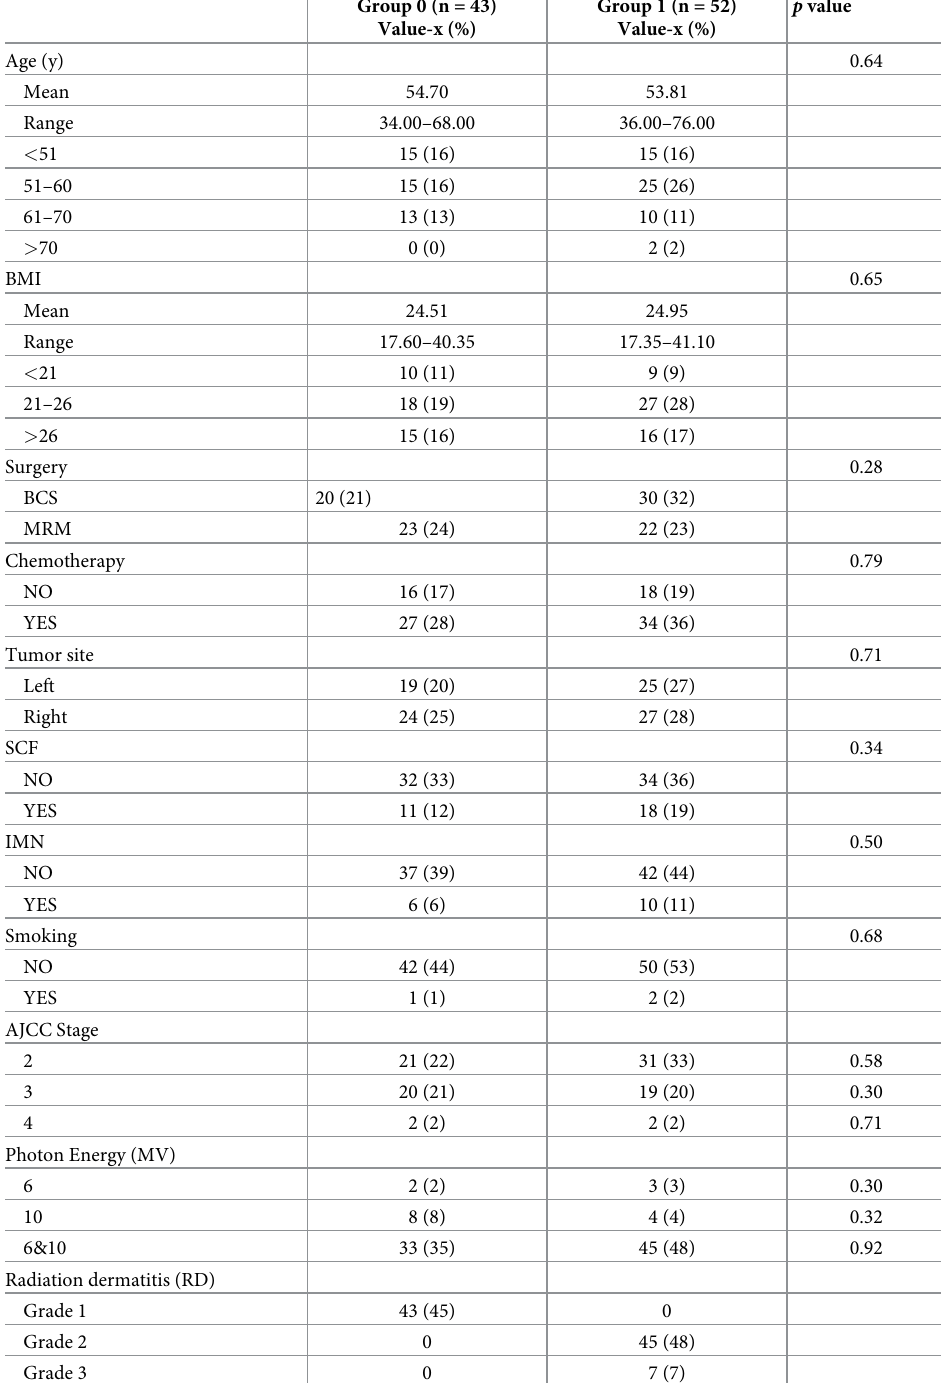
Table 1. Patients